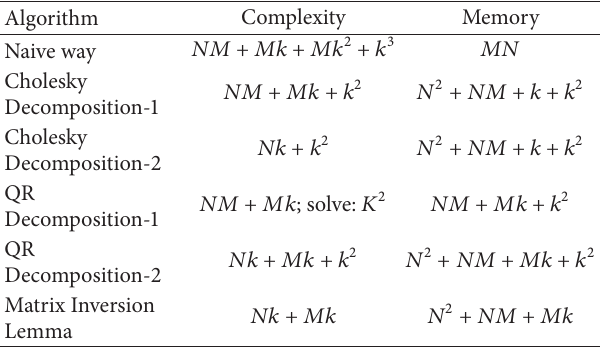
Table 1: Complexities and memory requirements for some OMP computational approaches